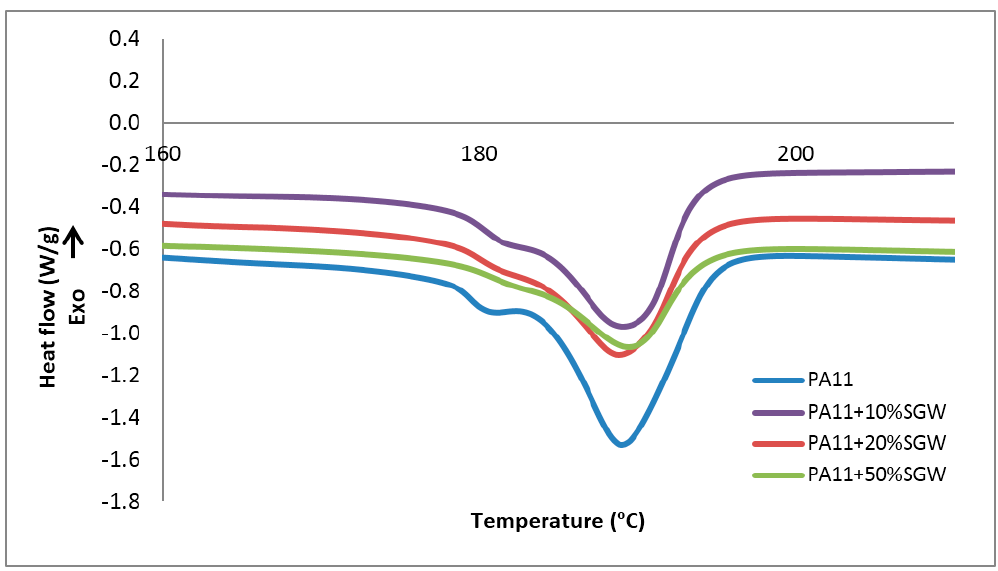
Figure 2. DSC thermographs of the melting point of PA11 and PA11 composites.